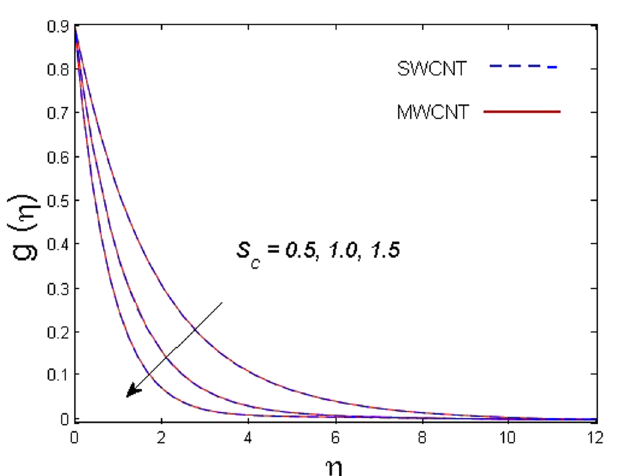
Figure 9. Outcome of R d on ( ) θ η .